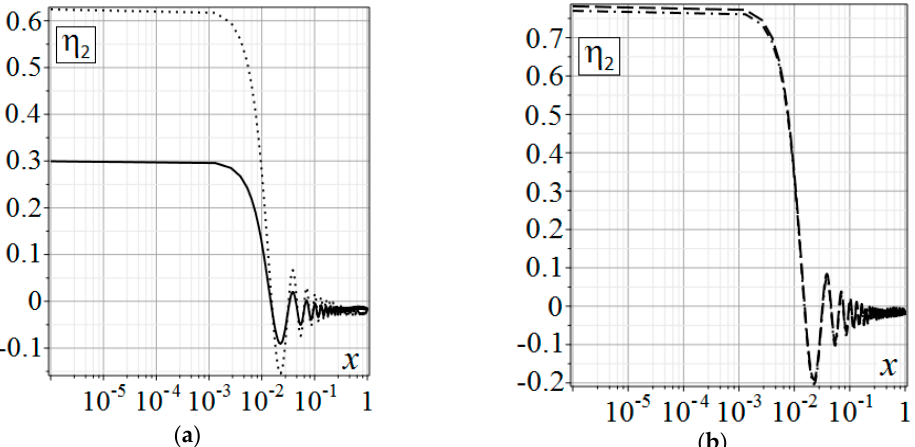
Figure 3. Concentration increment η 2 on x . ( a ) Implantation; and ( b ) annealing.